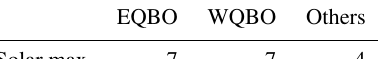
Table A1. Number of EQBO, WQBO, solar max, solar min and other years. EQBO WQBO Others